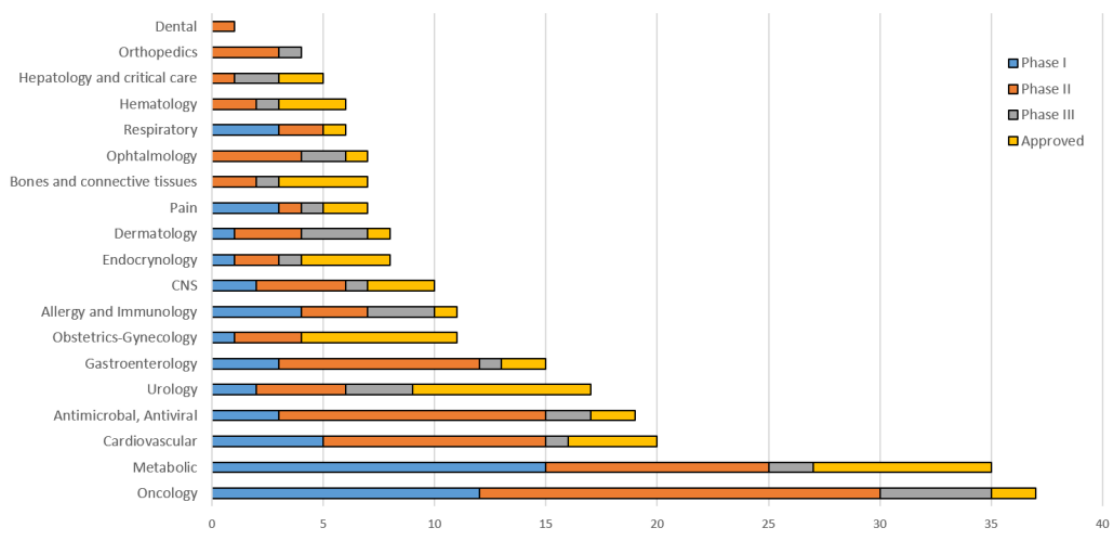
Figure 1. Peptides approved and in active development by therapeutic area.